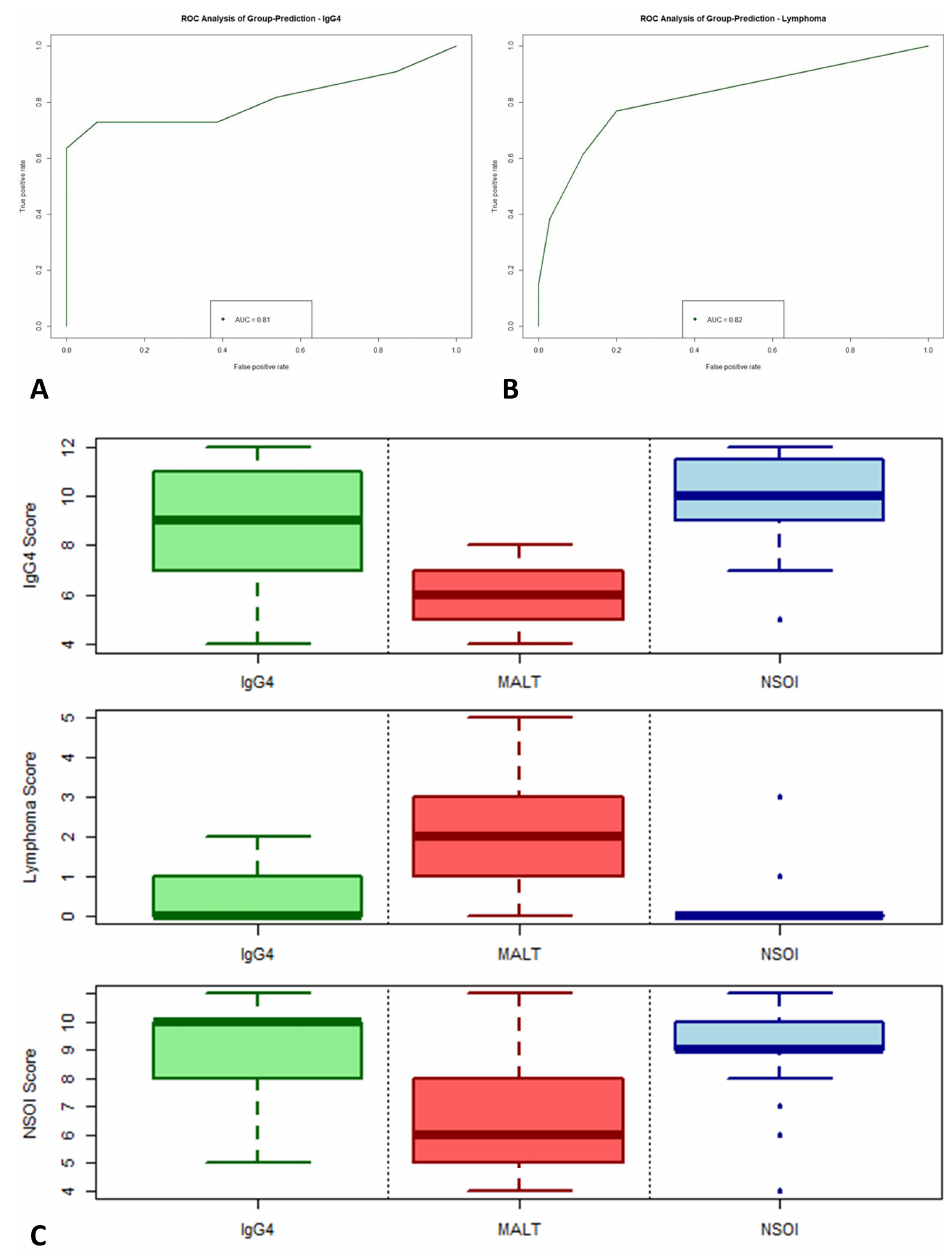
Figure 5. Validation of our logistic regression model based on the differently up- and downregulated genes. The validation cohort compromises 48 independent samples. ROC analysis of group-prediction for IgG4-ROD ( A ) and MALT lymphoma ( B ). Synopsis of all three scores ( C ).